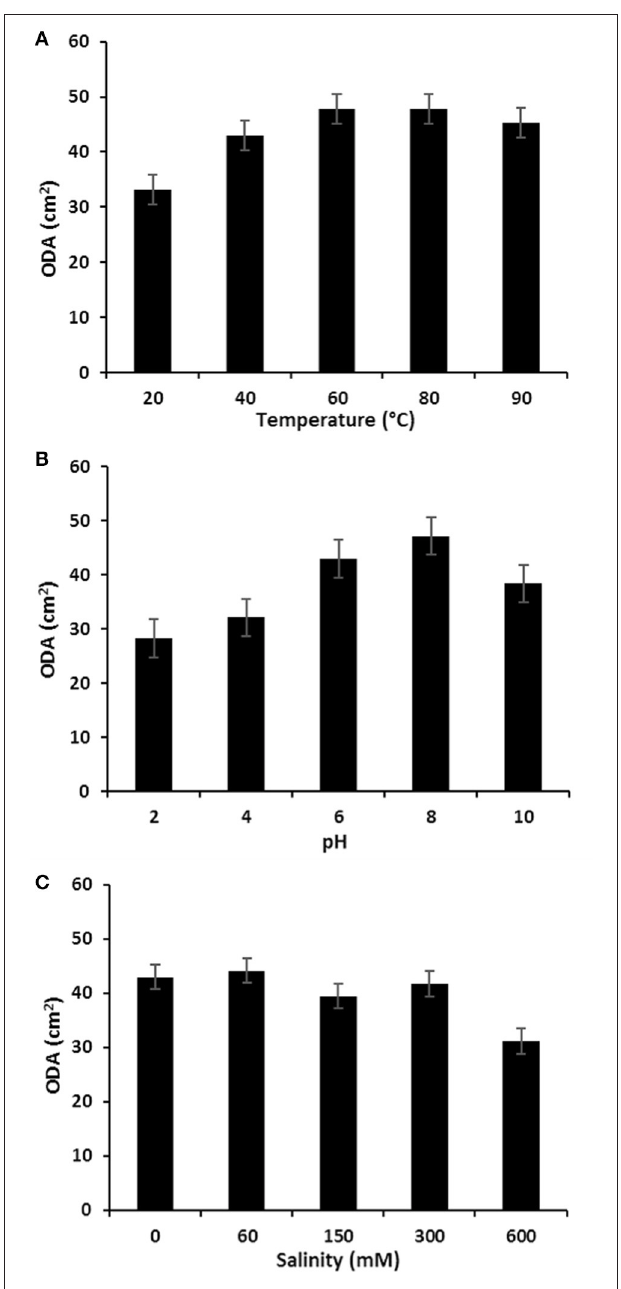
FIGURE 8 | (A) Temperature; (B) pH, and (C) salinity effects on the stability of glycolipid BS produced by P. rhizophila